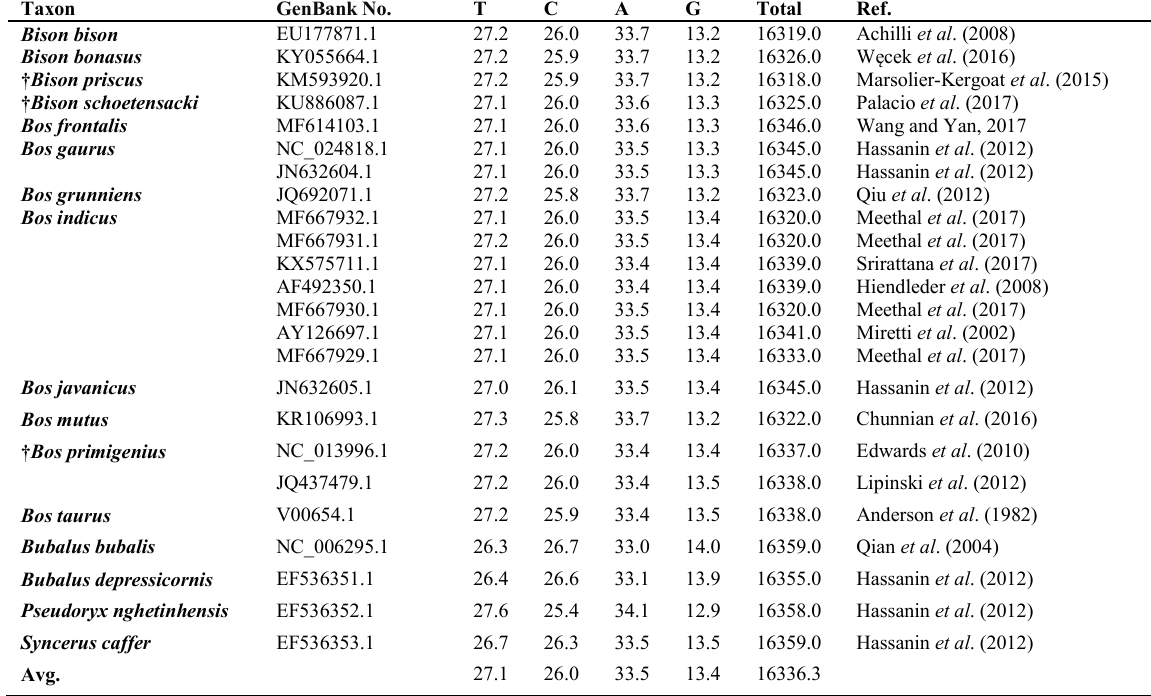
Table 1. The list of samples (in alphabetical order) with GenBank accession number. The nucleotide composition of the complete mitochondrial genome is given (n=24) . Taxon GenBank No. Bison bison